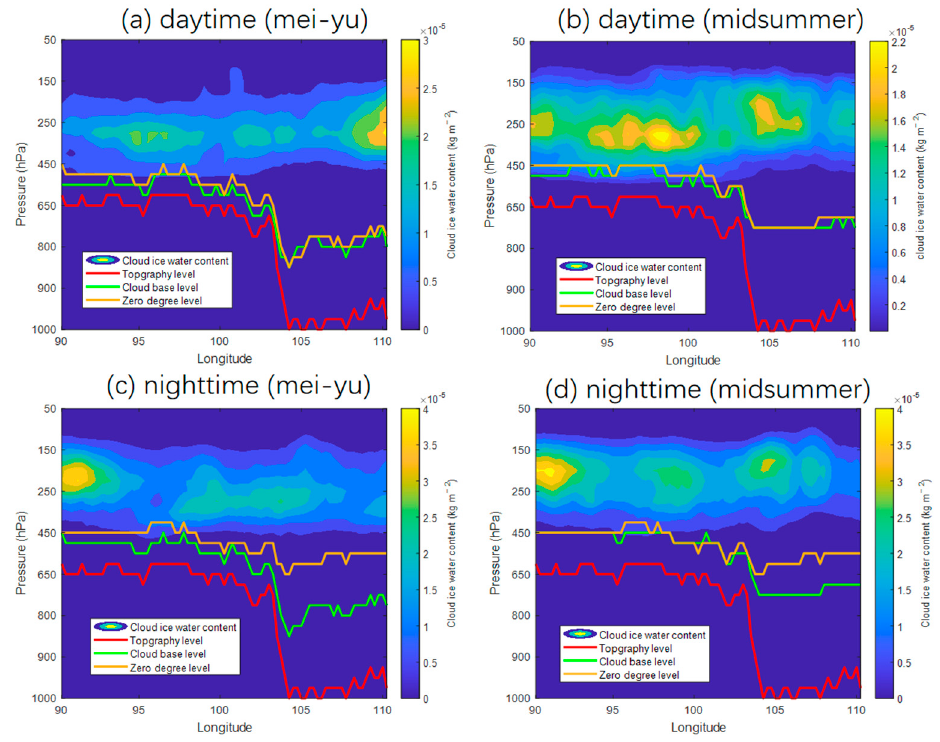
Figure 6. Similar with Figure 5, but for cloud ice water content.